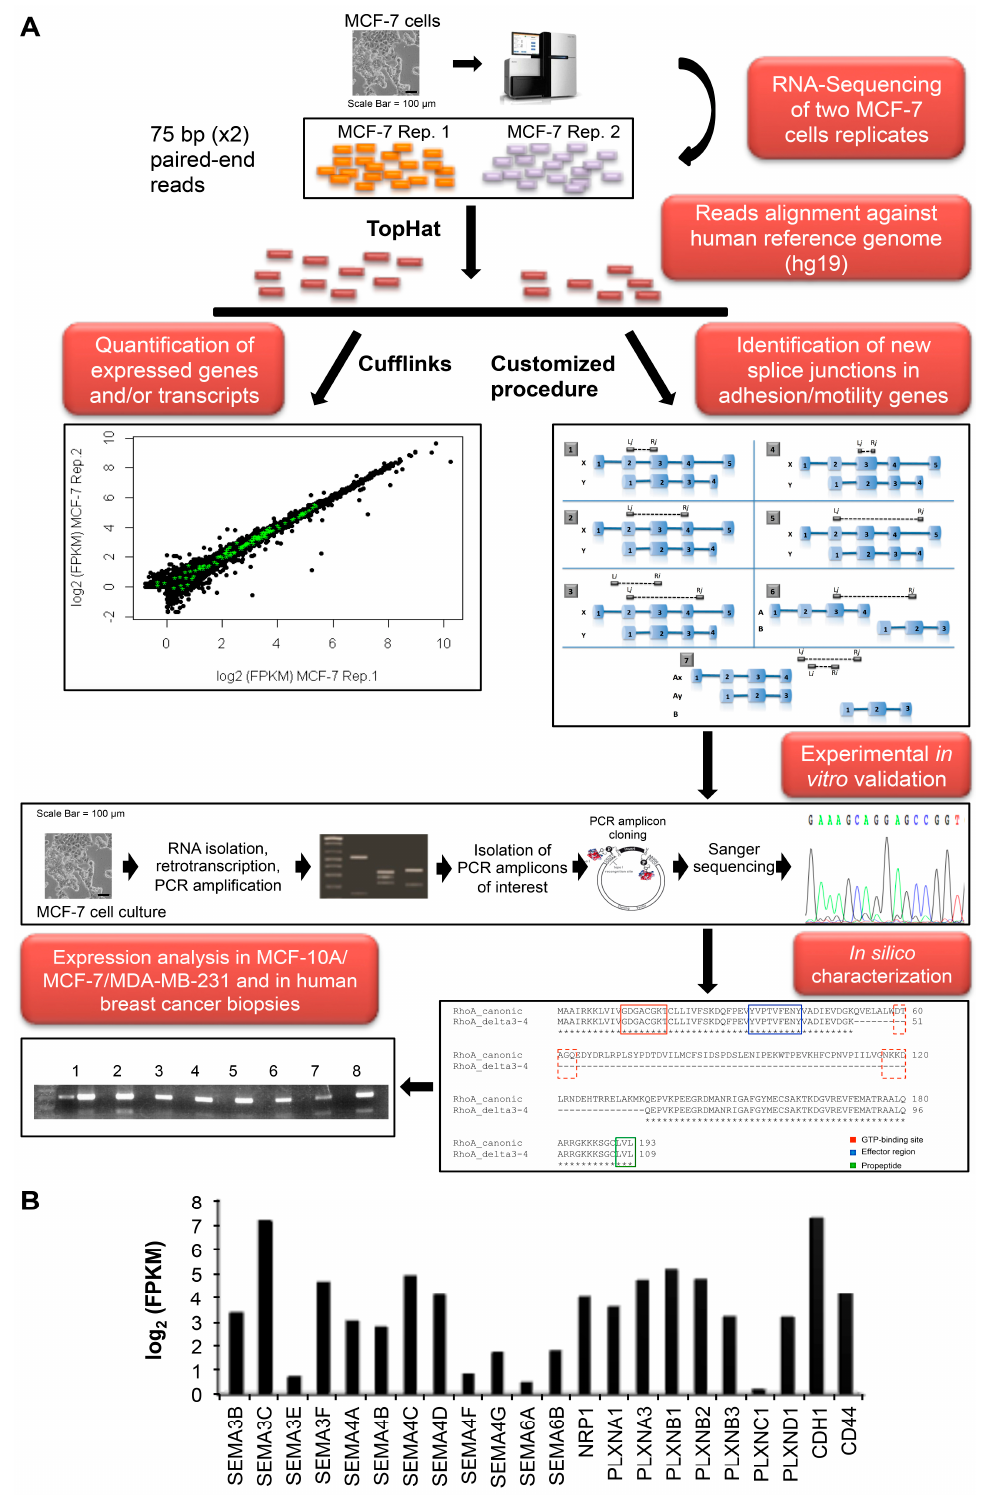
Figure 1. ( A ) Overview of RNA-Seq data processing and of the computational and experimental approach used for the identification and validation of the new spliced transcripts; ( B ) Barplot with log 2 normalized expression values (FPKM) of semaphorin/Plexin/Neuropilin—and of the adhesion markers CDH1 and CD44 —according to RNA-Seq data.